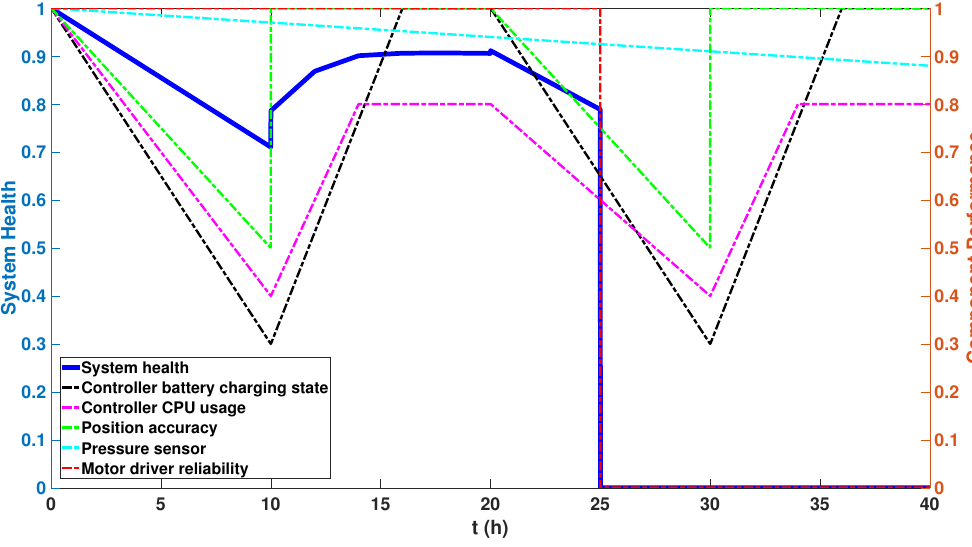
Figure 5. The simulation results of scenario case